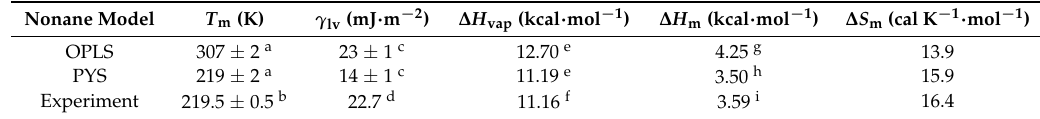
Table 2. Comparison of thermodynamic properties of pure PYS and OPLS